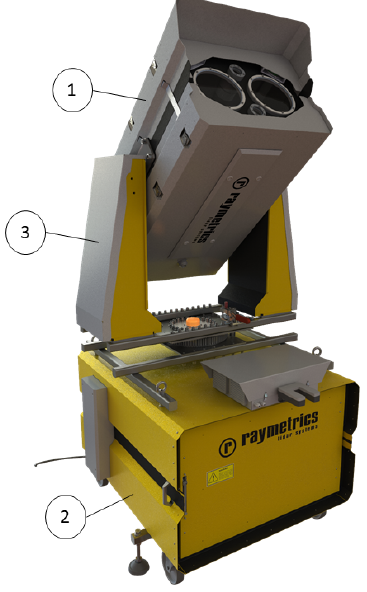
Figure 1. The lidar system, with the “head” part at the top (1), the “electronics compartment” at the bottom (2), and the “positioner” of the head